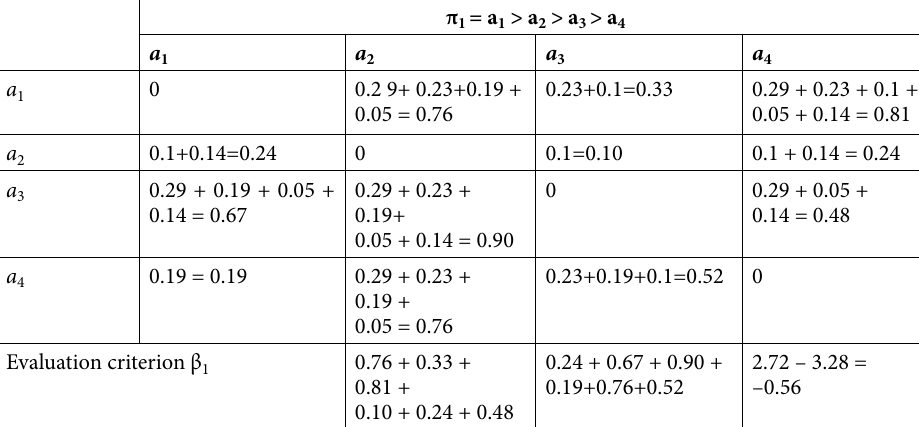
Table 2. Permutations and calculation process of evaluation criterion